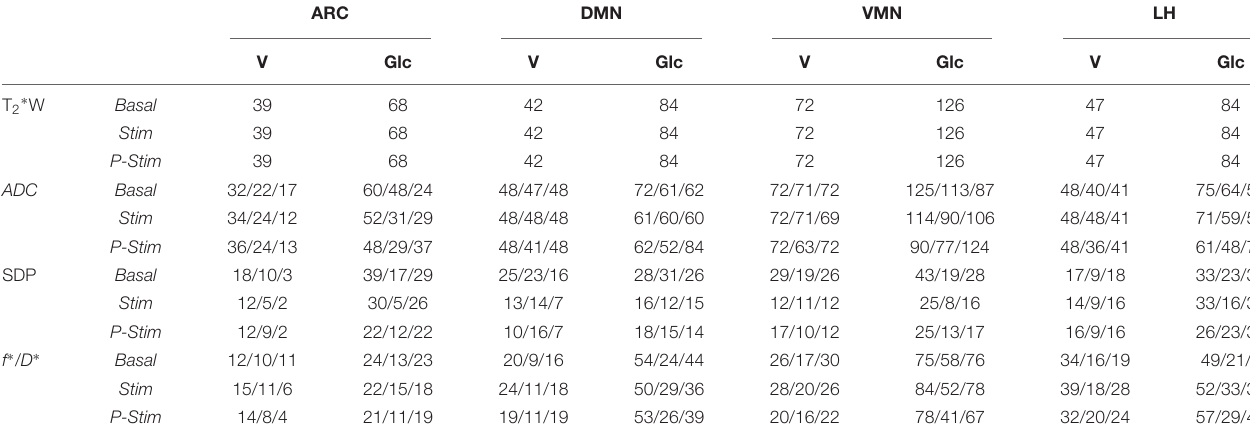
TABLE 1 | Number of sub-hypothalamic nuclei voxels for each